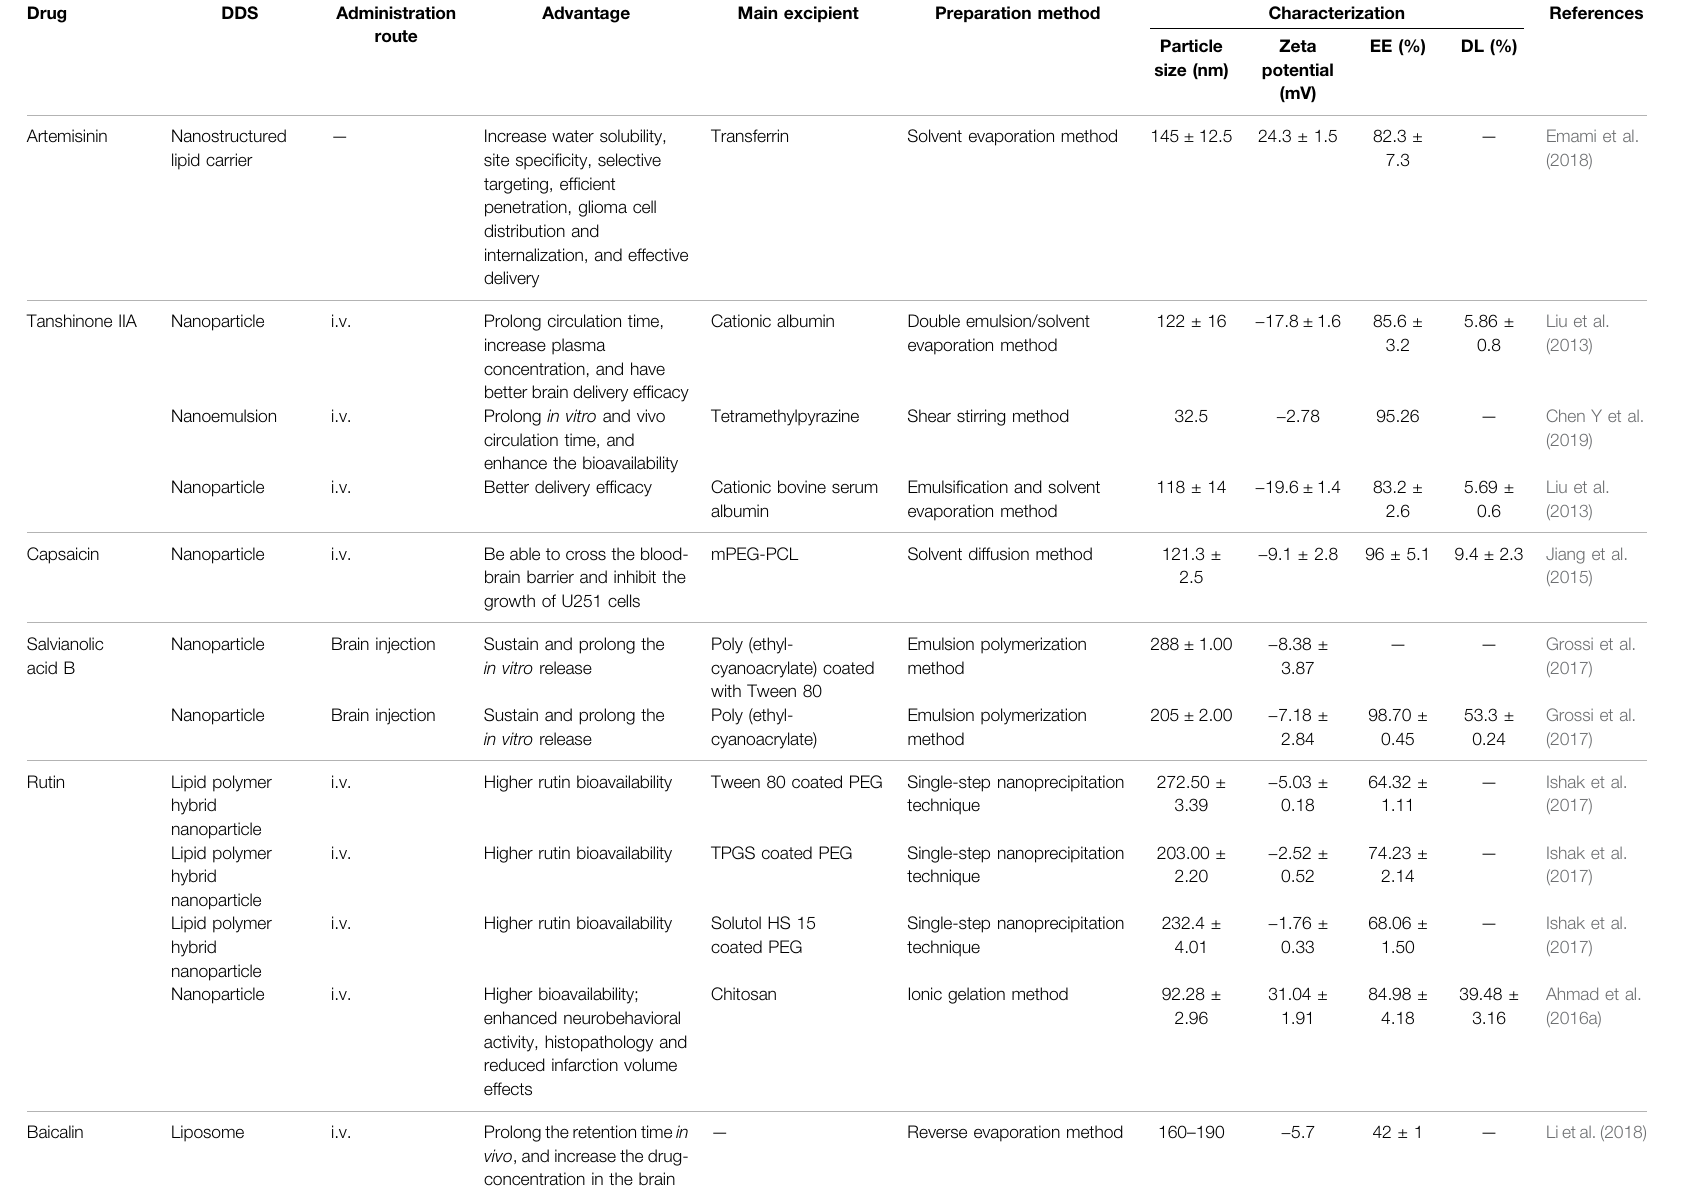
TABLE 1 | Characteristics of